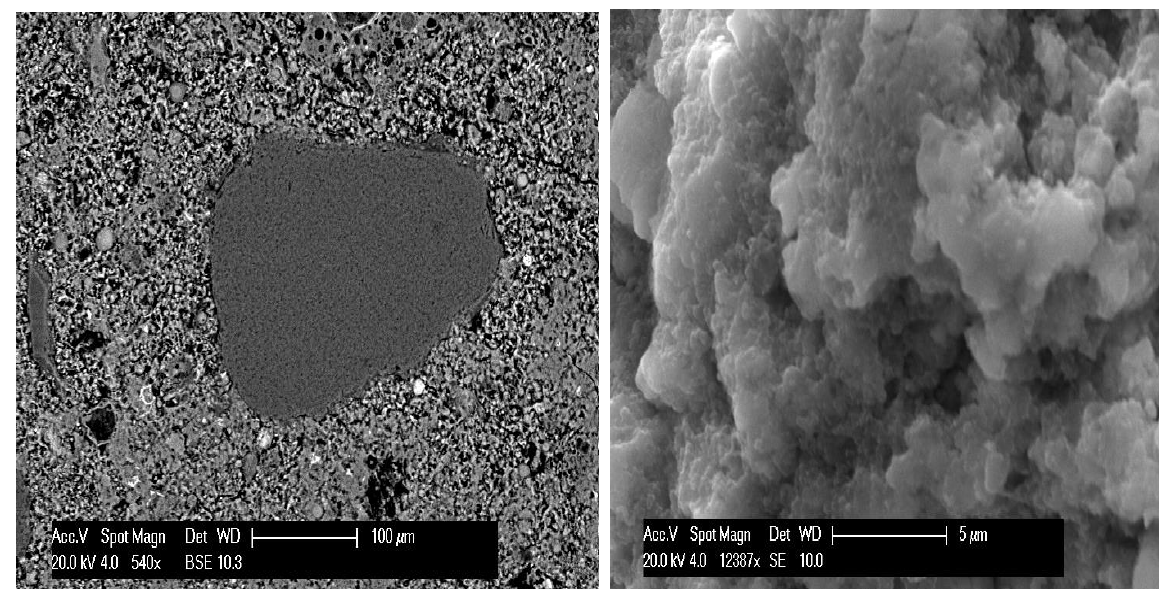
Figure 6. Scanning electron microscope views of the micro-structure.